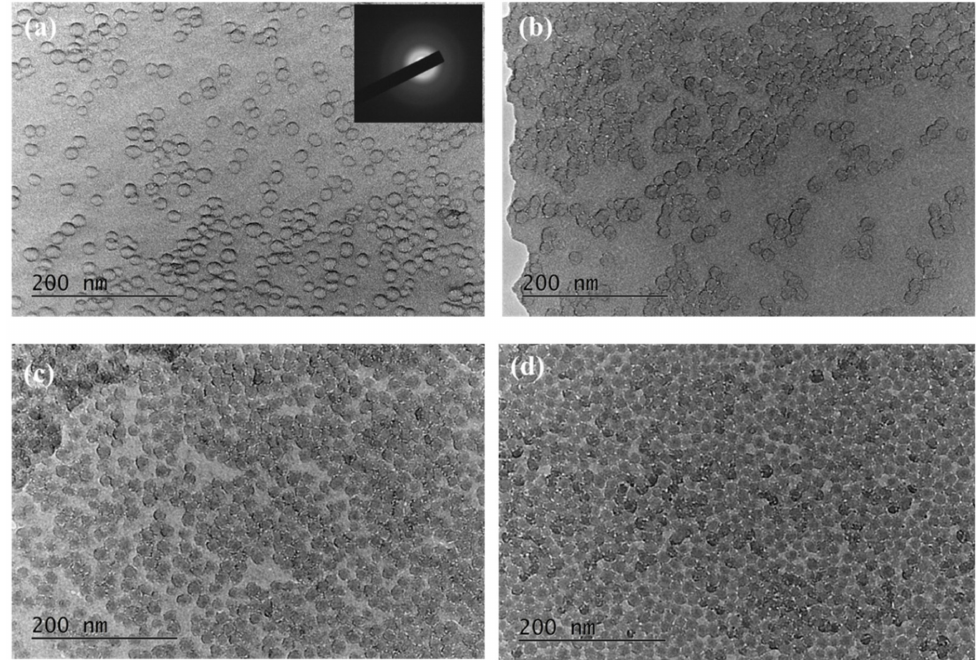
Figure 2. TEM images of porous films of Nb 2 O 5 prepared by mixing Nb sol and a colloidal solution of nanoparticles of SiO 2 (commercially available LUDOX ® ) in different volume fractions: 50:1 ( a ), 20:1 ( b ), 10:1 ( c ) and 5:1 ( d ); Typical selected area electron diffraction (SAED) pattern is shown as an